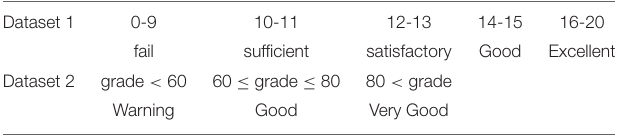
TABLE 5 | The details of the two datasets used in